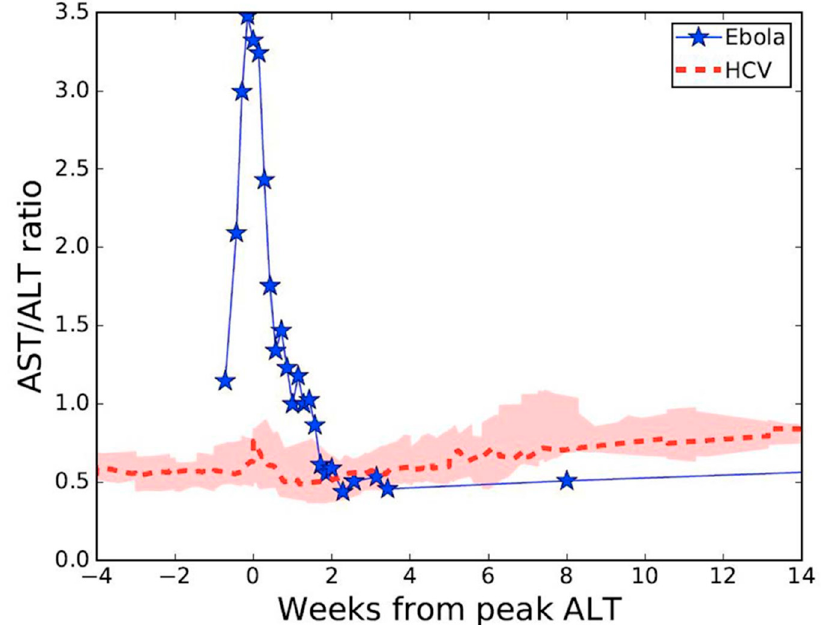
Figure 2. Aspartate and alanine aminotransferase (AST/ALT) ratio kinetics during acute Ebola virus ( n = 1) [5], or acute hepatitis C virus ( n = 28) [8,9] infections. Pink shaded region represents first and third AST/ALT ratio quartiles.